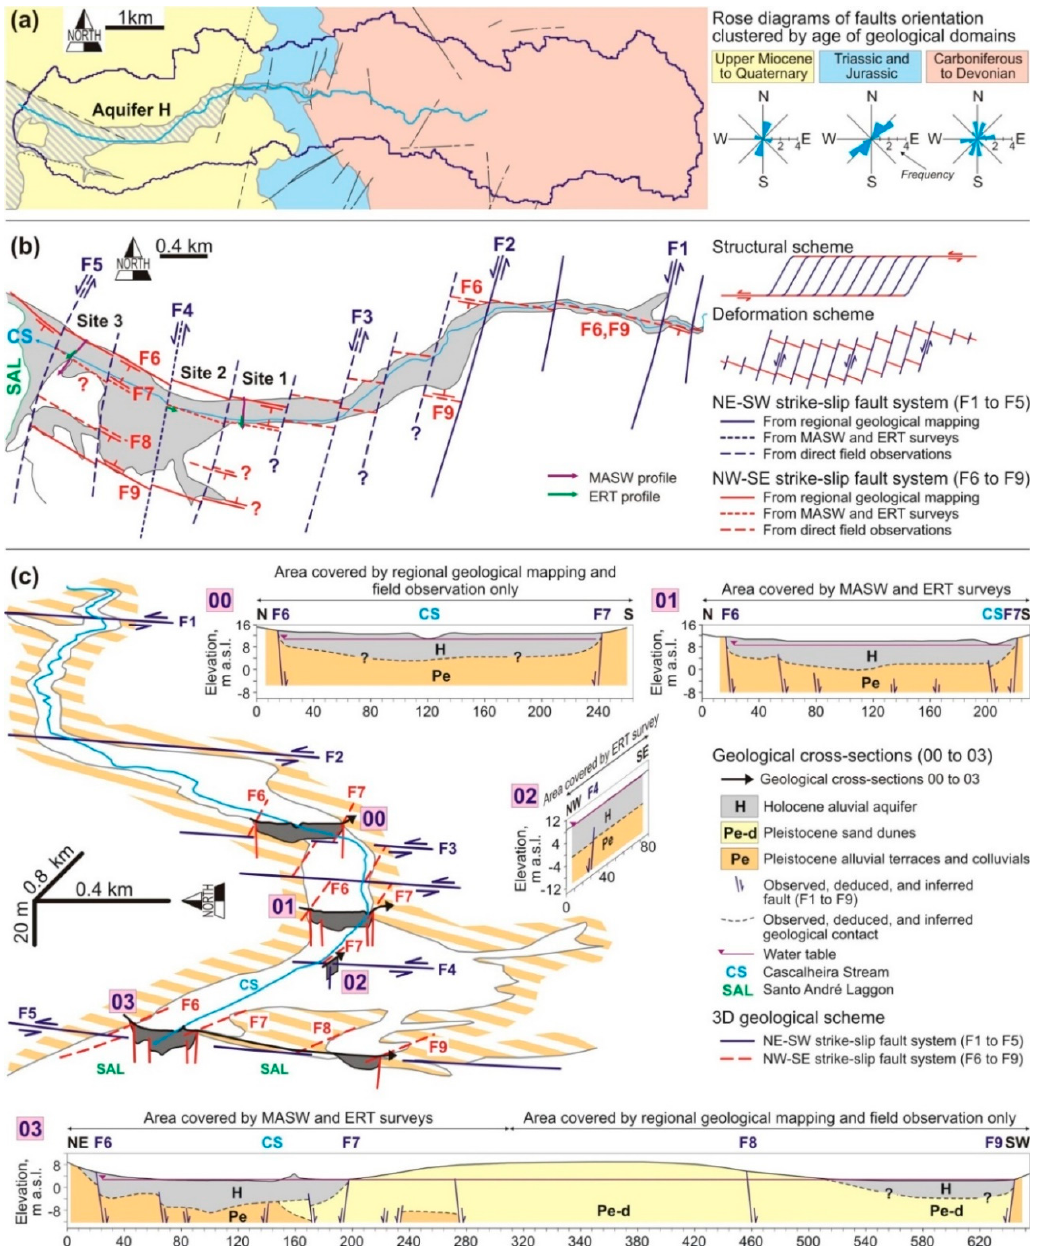
Figure 8. ( a ) Regional tectonic setting of CSB area, after [43–45], showing rose diagrams of faults orientation clustered by age of geological domains as in Figure 1b. ( b ) Local tectonic setting of aquifer H after [40,43,47], direct field observations, aerial photographs, and MASW and ERT surveys, showing theoretical structural and deformation schemes, and the conjugate NW–SE and NE–SW strike-slip fault systems. ( c ) Geological model of aquifer H, showing geological cross-sections 01 (site 1), 02 (site 2), and 03 (site 3) from integrated MASW (Figure 5) and time-lapse ERT (Figure 6) surveys at sites 1 to 3 and direct field observations, and a new geological cross-section called 00 and the southern end of the geological cross-section 03 inferred from geological mapping and direct field observation only; the vertical-to-horizontal scale ratio being